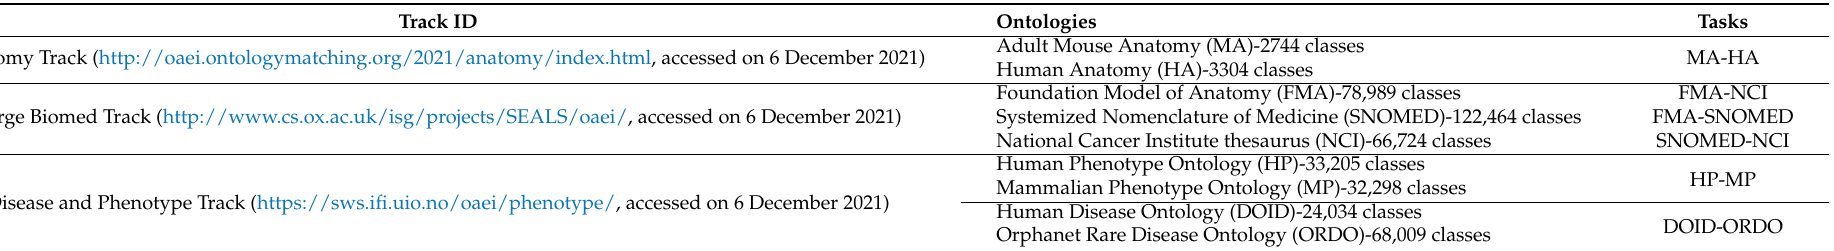
Table 1. Brief description on OAEI’s biomedical